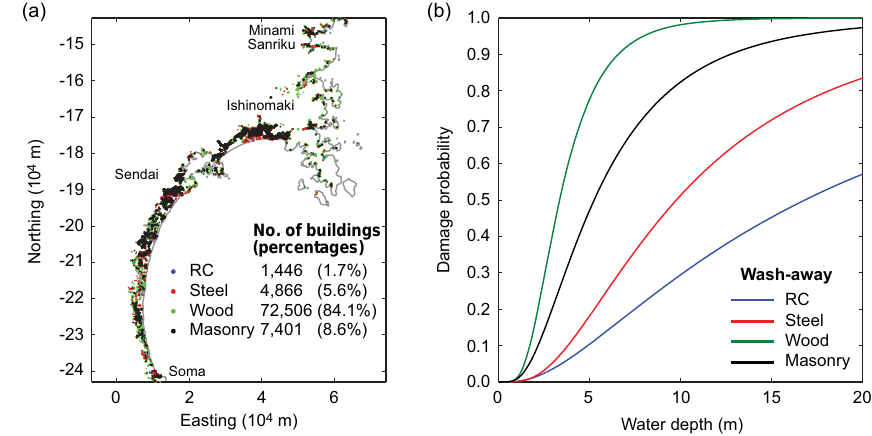
Figure 5. (a) Spatial distribution of buildings in Miyagi Prefecture, and (b) tsunami fragility curves for wash-away damage state. The map in (a) is shown in the Japanese plane orthogonal coordinate